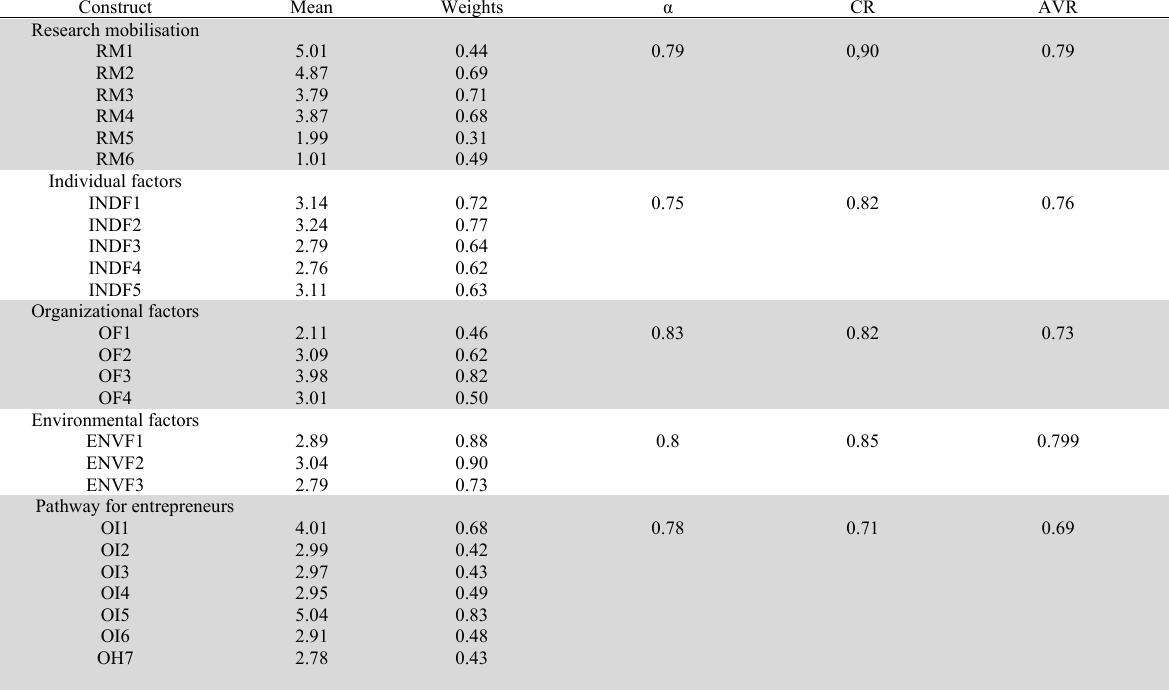
Indicators for the evaluation of the measurement model